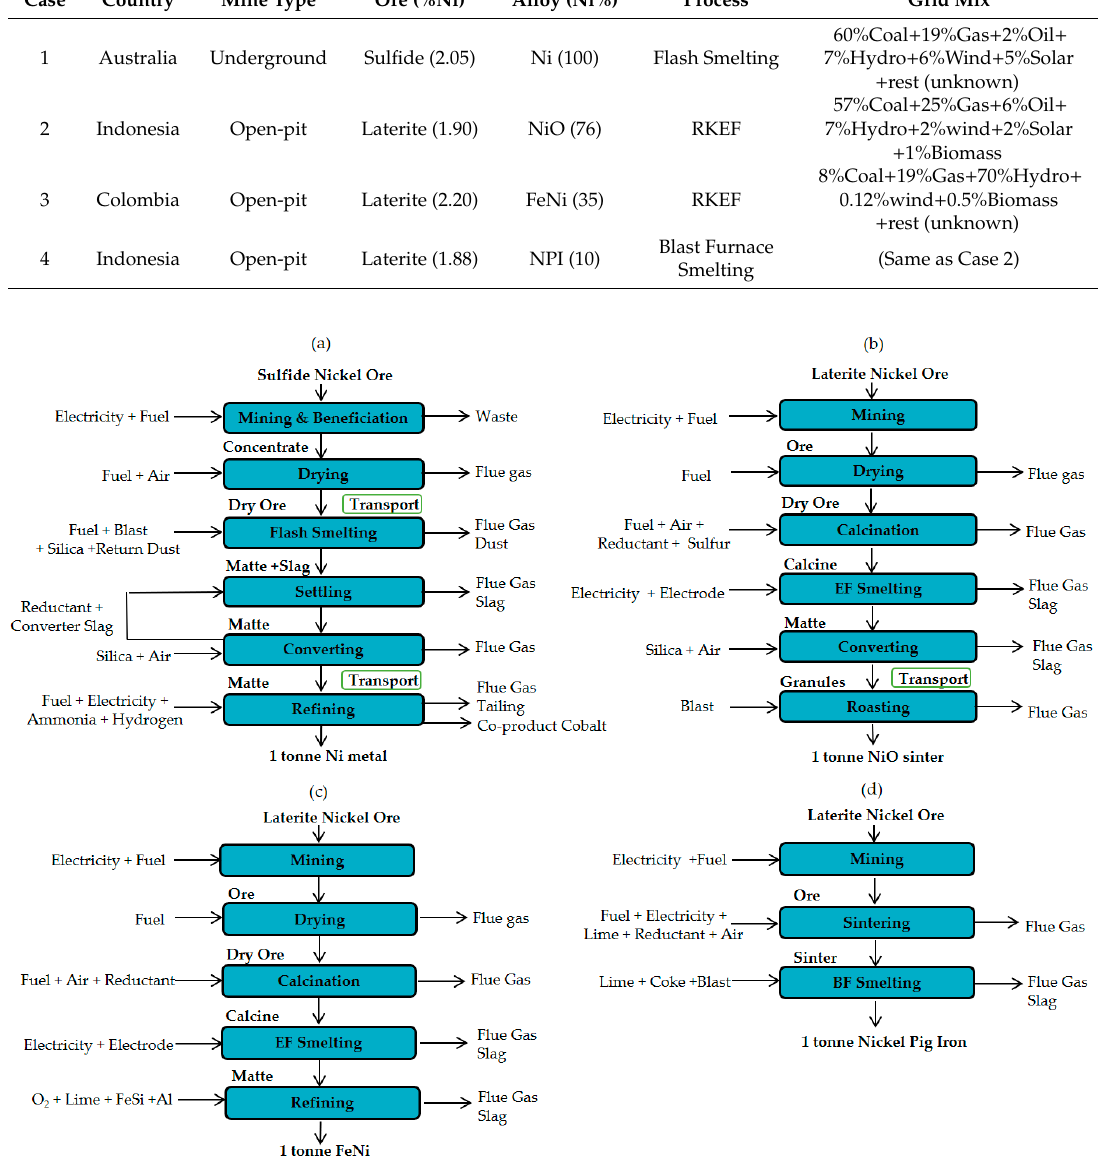
Table 4. Basic information of the studied cases [23,46–50].